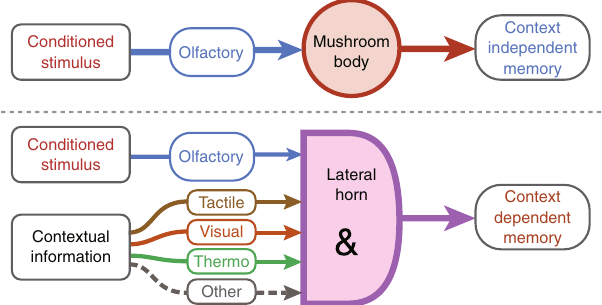
Fig. 6 Model of cLTM retrieval: Multisensory integration in the LH. Top: Conditioning stimulus (olfactory cue) is suf fi cient to retrieve